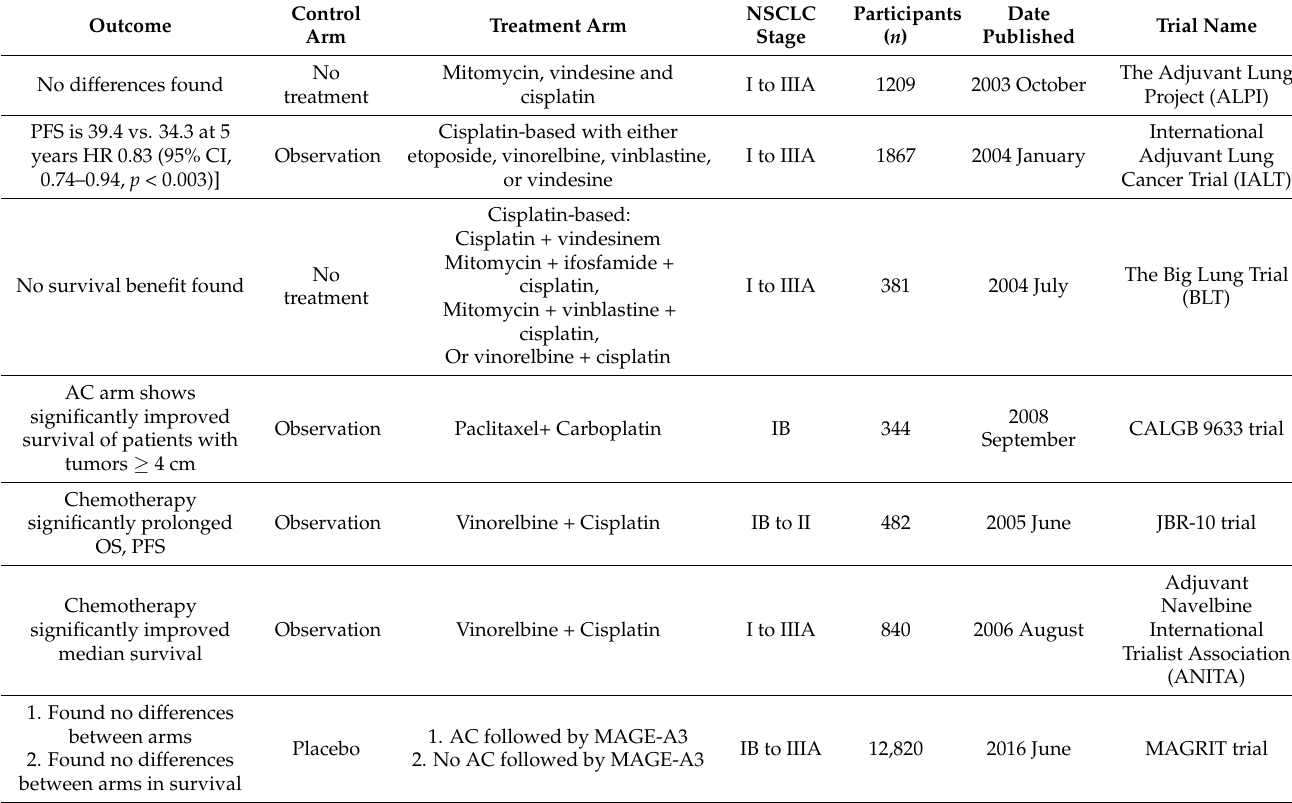
Table 2. Past clinical trials that included adjuvant therapy uncharacterized for EGFR status in patients with completely resected NSCLC.